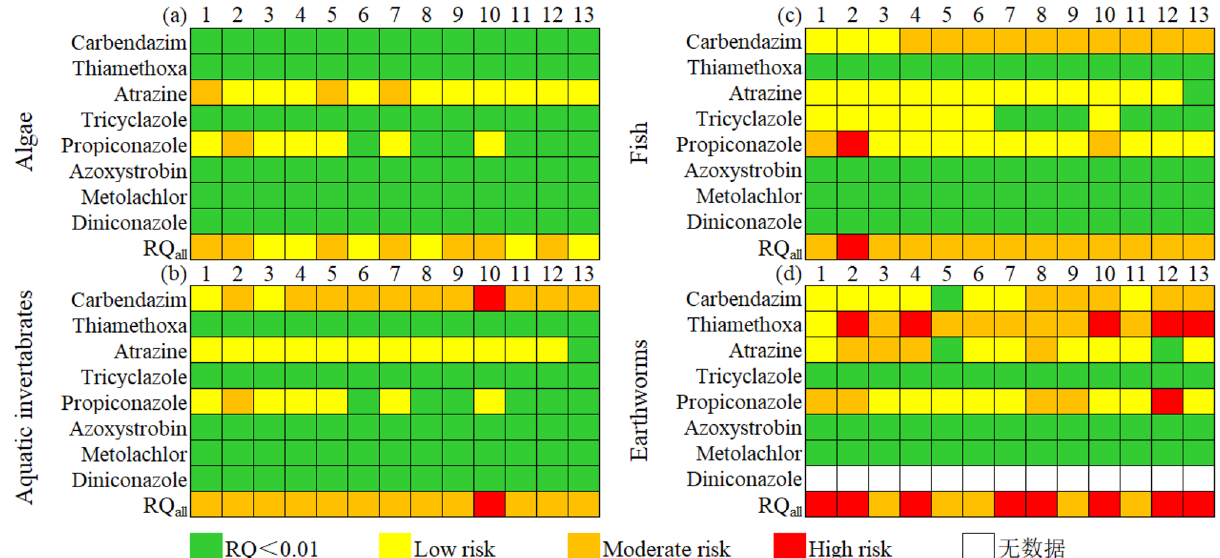
Figure 2. Heat map of RQ values of pesticides to algae ( a ), aquatic invertebrate ( b ), fish ( c ), and earthworm ( d ). Most of pesticides almost have no aquatic risk (RQ < 0.01), but carbendazim and propionazole deserved attention. The RQ all were in the range of 0.4541–3.327 (earthworm), 0.0239–0.4552 (algae), 0.1094–1.103 (aquatic invertabrates), and 0.1657–1.923 (fish),